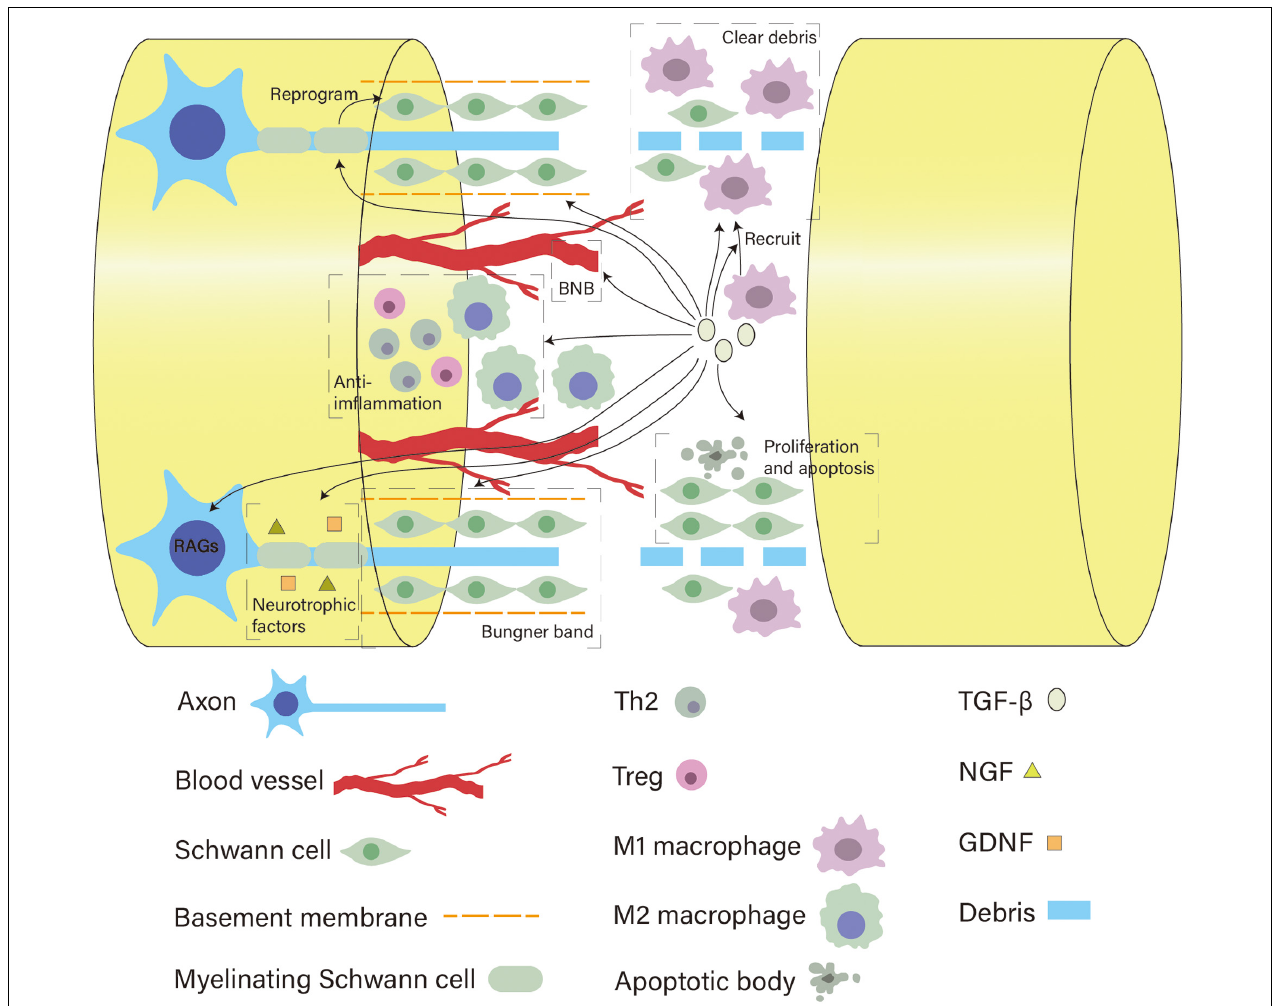
FIGURE 3 | Overview of the diverse roles of TGF- β in neural regeneration. After nerve injury, TGF- β helps recruit macrophages and enhances the capacity of macrophages and SCs to clear myelin debris by upregulating the expression of MerTK receptors and MMPs, respectively. Meanwhile, it initiates reprogramming of SCs, regulates their number, protects the basement membrane, and promotes their migration and alignment to form bands of Büngner. TGF- β can act on pericytes and tight junction proteins to modulate the BNB permeability to regulate the local injury milieu. As a potent anti-inflammatory cytokine, it polarizes M1 macrophages into the M2 phenotype and sustains Tregs and Th2 cells to create a growth-supportive environment. In addition, TGF- β promotes neuronal growth capacity by activating RAGs of neurons and facilitating the neurotrophic effects of NGF and